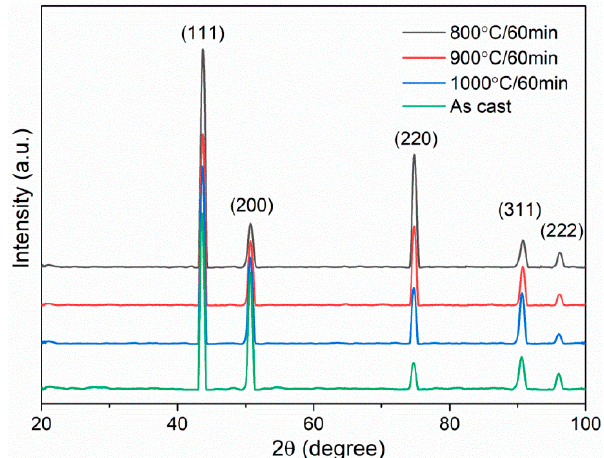
Figure 1. XRD curves of as-cast HEA specimens and specimens after cold rolling and subsequent annealing.